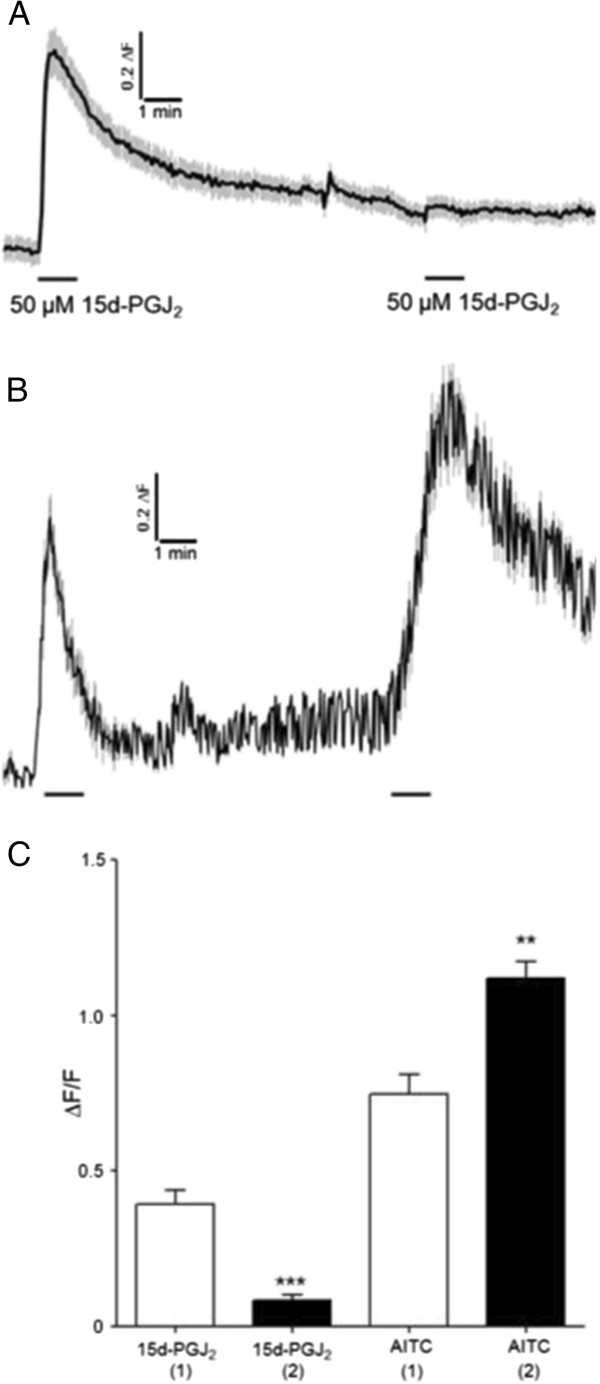
Homologous desensitization of 15d-PGJ2 vs. AITC is dependent on agonist concentration. Homologous sensitization and desensitization are agonist- and concentration-dependent. In contrast to 50 μM 15d-PGJ2 (A), responses to 50 μM AITC sensitize (B) significantly (C). Traces show mean ± SEM of ~30-60 DRG neurons. Values in C represent the peak response of neurons under each condition. **p < 0.01, ***p < 0.001. Data were analyzed using a paired, two-tailed Student’s t-test.